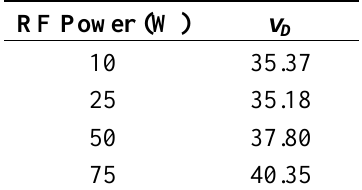
Table 1. Abbe-numbers for pp–GT thin